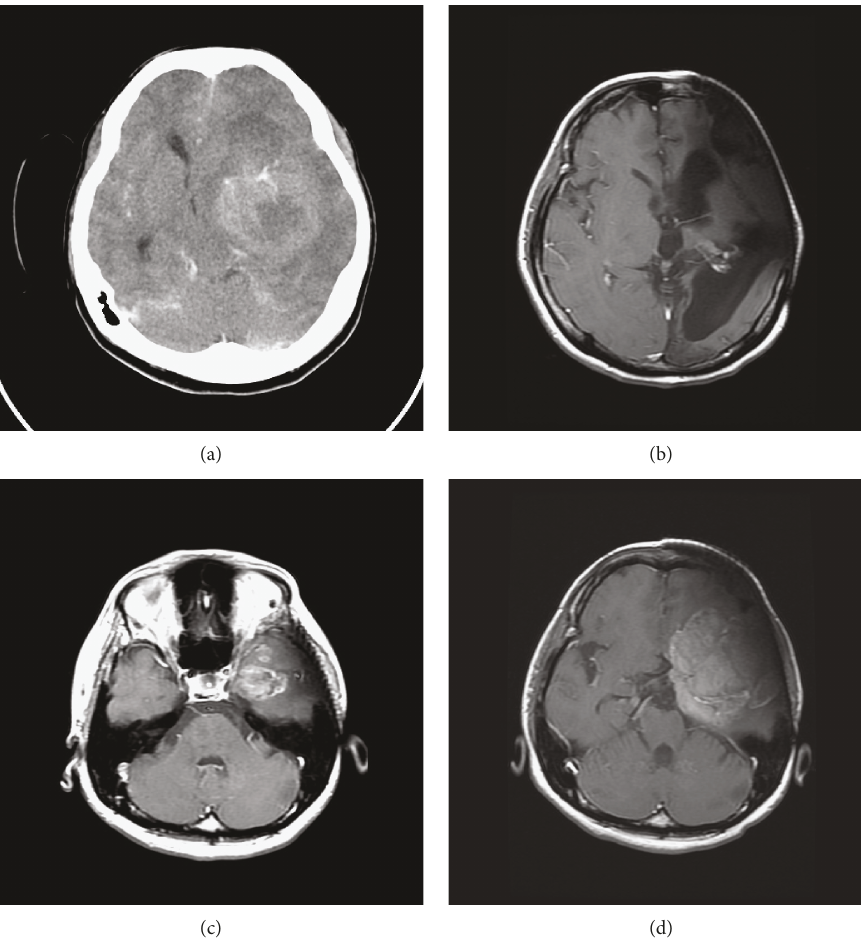
Figure 1: (a) Brain computed tomography in December 2006 showed an enhanced brain tumor over the left temporal region with mass e ff ect; (b) no obvious recurrent tumor was found by brain MRI in 2013; (c) recurrent tumor was found by MRI in 2014, before the second surgery; and (d) brain MRI in May 2015, before the third surgery, revealed tumor